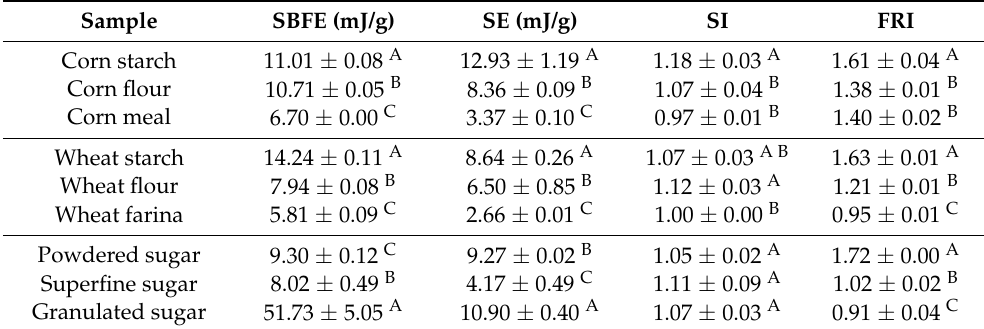
Table 2. Dynamic flow properties of food powders.